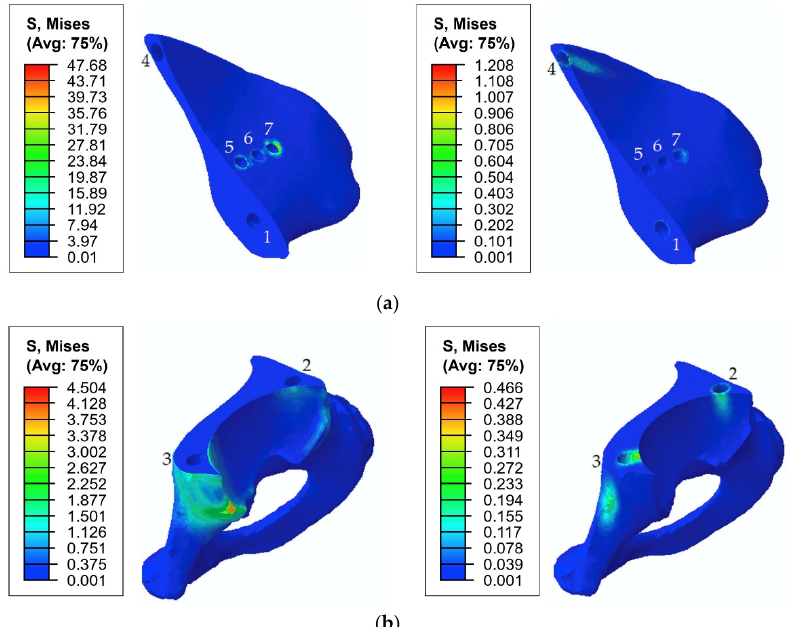
Figure 10. Equivalent von Mises stress (MPa) distribution in the bone tissue caused by a pretension load of 1000 N: ( a ) the upper part of the resected pelvic bone; ( b ) the lower part of the resected pelvic bone. The images on the left show the stresses in the cortical tissue, and the images on the right show the stresses in the spongy tissue.